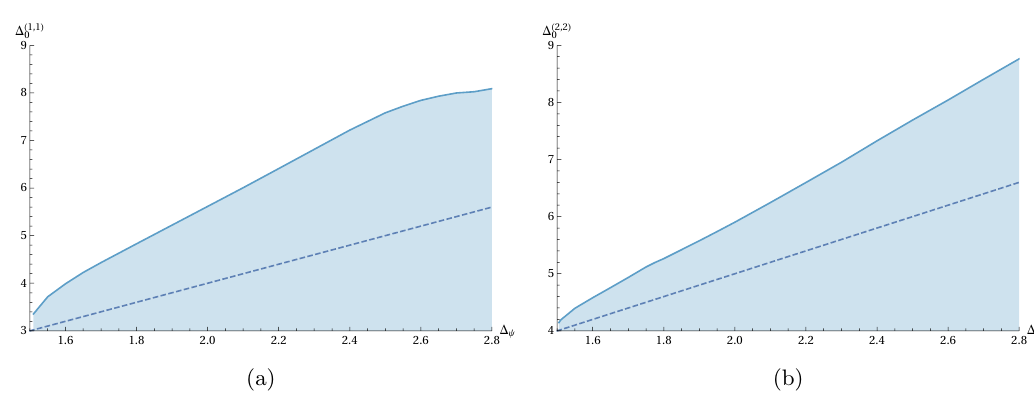
Figure 15 . Left: upper bound on the second (1 ; 1) TS operator appearing after the conserved current J . Right: upper bound on the second (2 ; 2) TS operator appearing after the conserved stress tensor T . The bounds have been computed at (cid:3) = 16. The dashed lines represent the GFT lines.